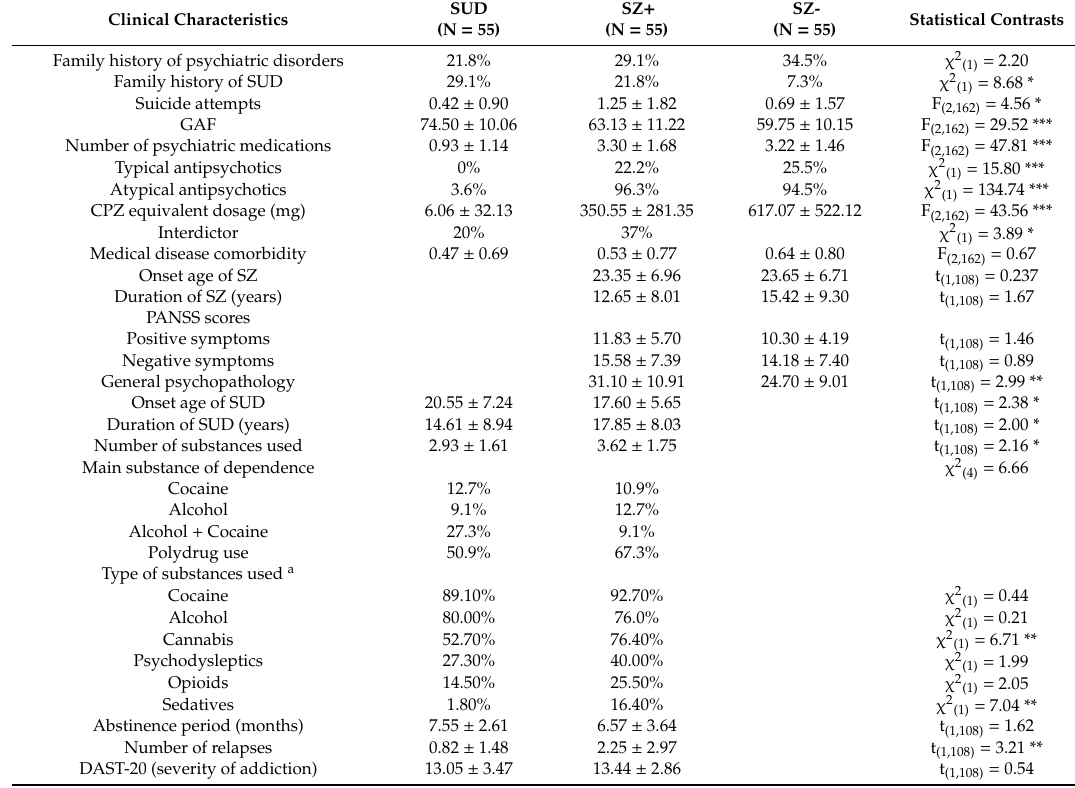
Table 2. Clinical data for the three groups. Mean, standard deviation or percentages, and statistical